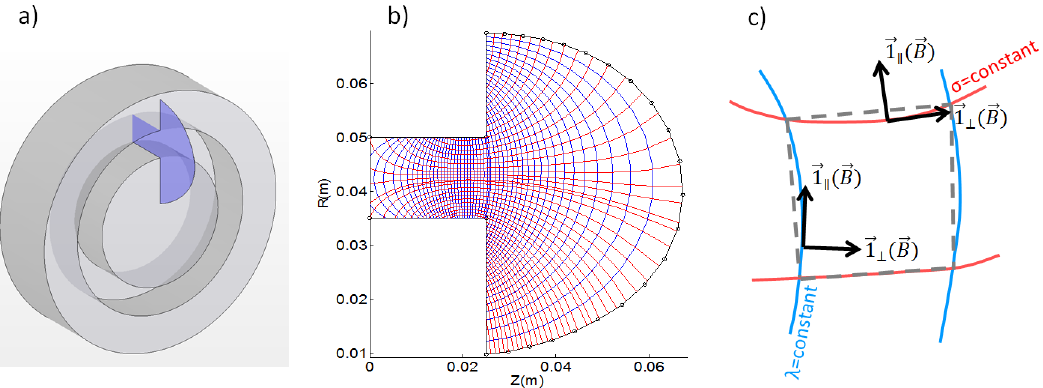
Figure 1. ( a ) The marked region represents a typical axisymmetric simulation domain for a Hall Effect Thruster geometry; ( b ) Magnetic Field Aligned Mesh for the SPT-100 Hall Effect Thruster magnetic topology; ( c ) Detail of a mesh